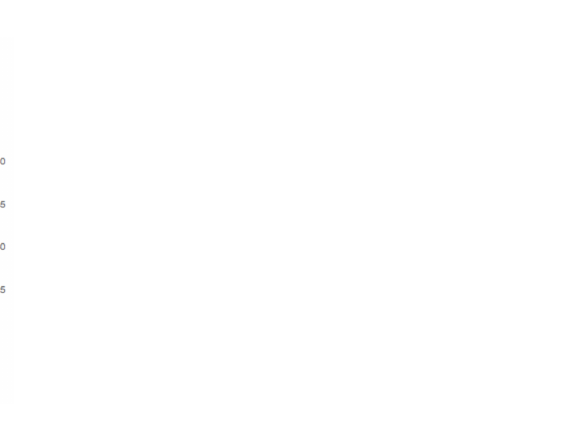
Figure 5. Multitask map of the fractal dimension in the five types of EEG ( X -axis) and in the six analyzed electrodes ( Y -axis). Table 3. p -values of the pairwise comparison hypothesis test of the EEG types in each channel (F3, F4, O1, O2, T3, and T4) for the fractal dimension. The values of p < 0.001 are highlighted in red color, 0.01 < p < 0.001 in yellow color, and 0.01 < p < 0.05 in green color. (The meaning of the abbreviatures is given in page 4).